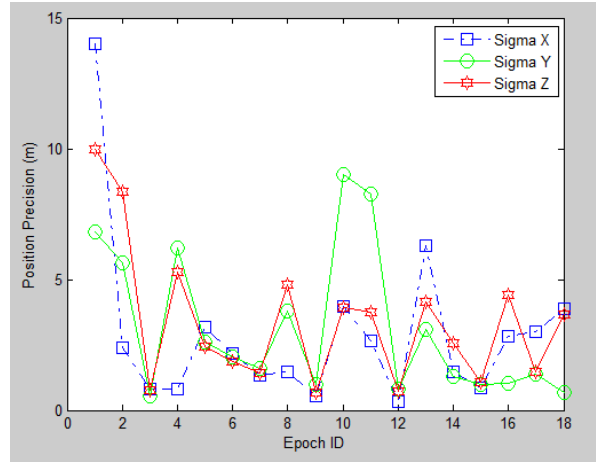
Figure 20. Position precision for the 18 epochs.